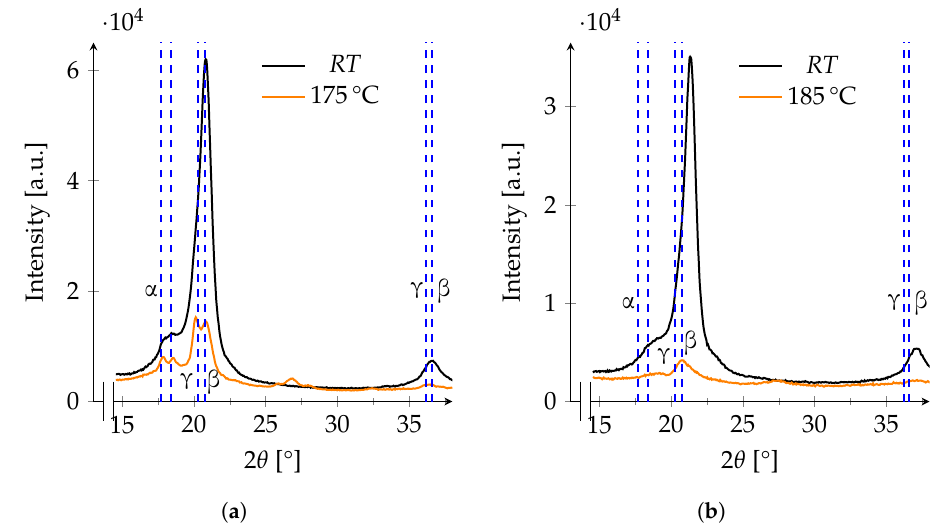
Figure 8. XRD patterns of two films annealed at 175°C ( a ) and 185°C ( b ) before and after annealing. The blue dashed lines at 17.7° and 18.4° refer to the expected main reflections of the α -phase, while the lines at 20.75° and 36.6° refer to those of the β -phase and the lines at 20.3° and 36.2° to those of the γ -phase.